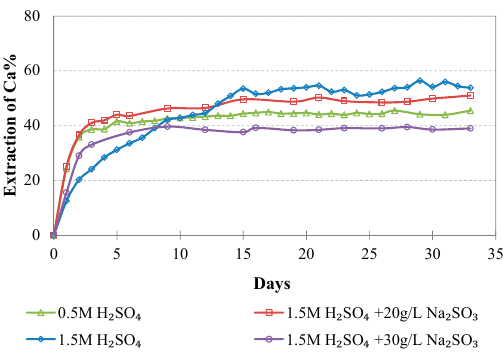
Figure 10. Evolution of % Ca extraction vs time during LAI leaching for different tests. Minerals 2018 , 8 , x FOR PEER REVIEW